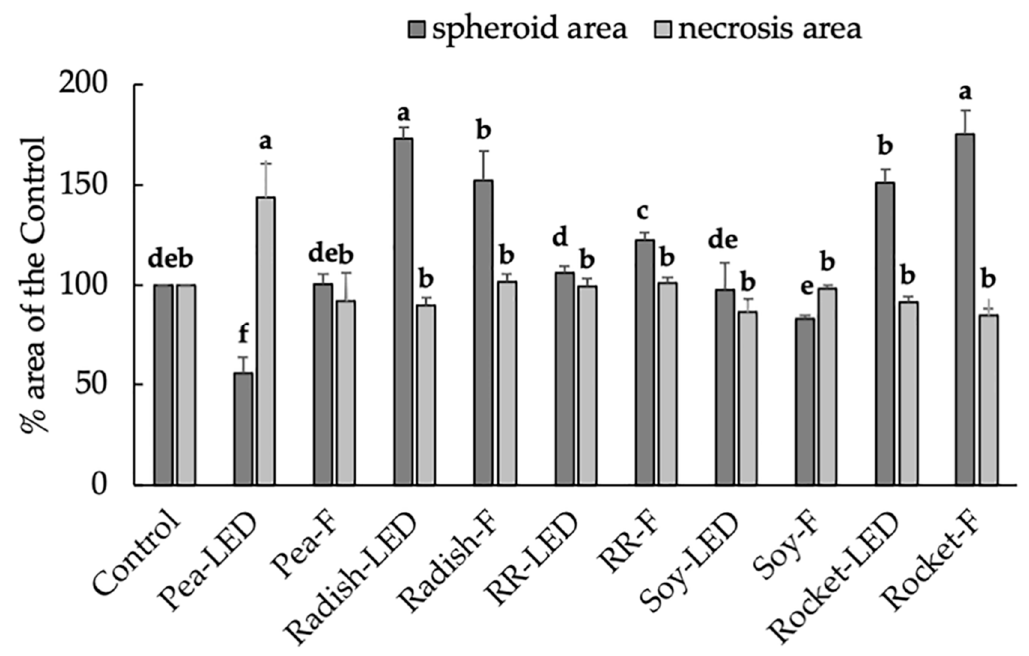
Figure 9. The anti-proliferative (spheroid area) and pro-apoptotic effects (necrosis area) on A673 exposed for 120 h to 40 µ L green pea, radish, Red Rambo (RR), soy, and rocket microgreens, cultivated under LED and fluorescent (F) lighting. Values are the mean ± SD of six replicates ( n = 6). The different lowercase letters (a–e) represent significant differences between the microgreen species under different lighting ( p < 0.05) for spheroid area and necrosis, respectively, as determined from a one-way ANOVA.